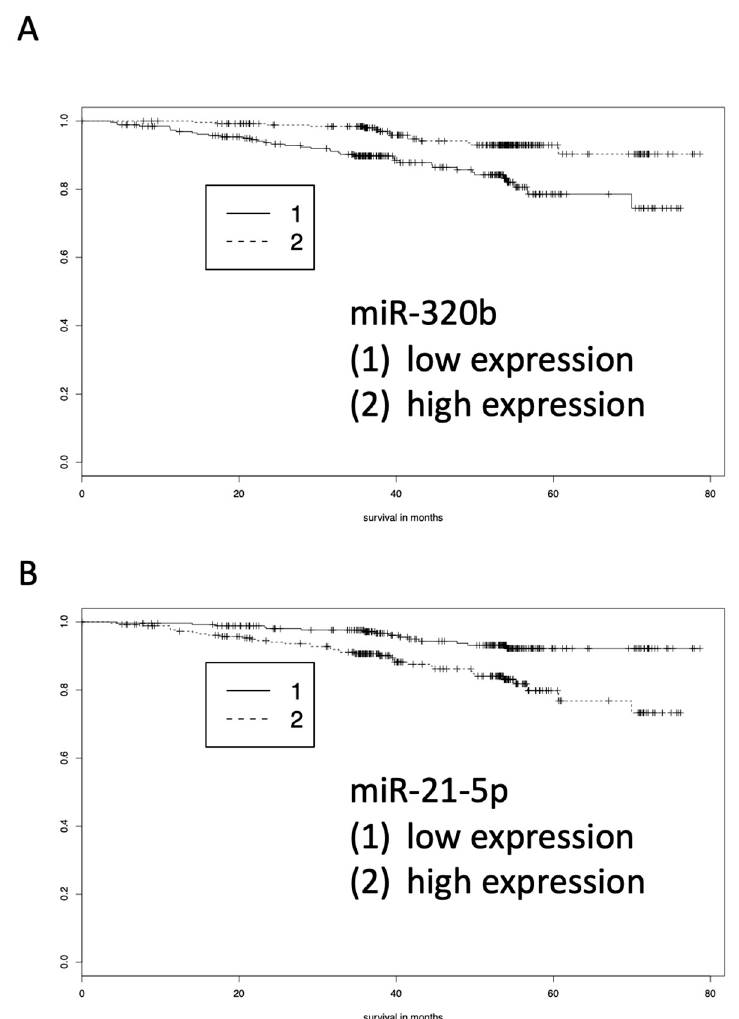
Figure 3. Kaplan-Meier analyses of blood-born miRNA pattern determined by array analysis. ( A ) MiR-320b indicates longer survival of COPD patients who show higher abundance of miR-320b. ( B ) MiR-21-5p indicates longer survival of COPD patients who show lower abundance of miR-21-5p.